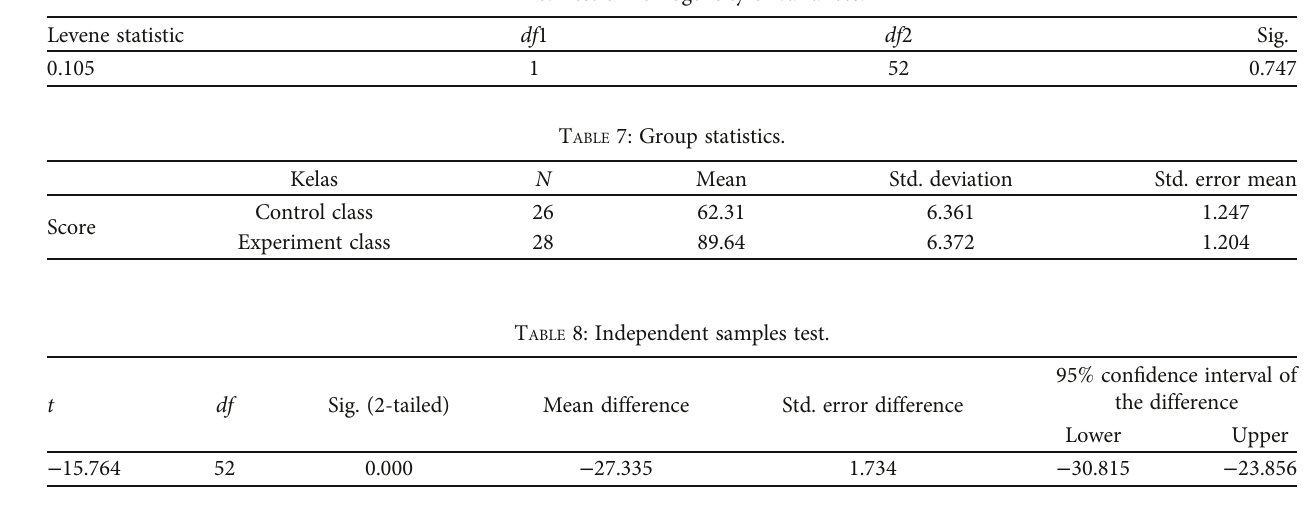
T ABLE 9: Comparison of student learning outcomes in the experimental class and the control class. Information Average learning